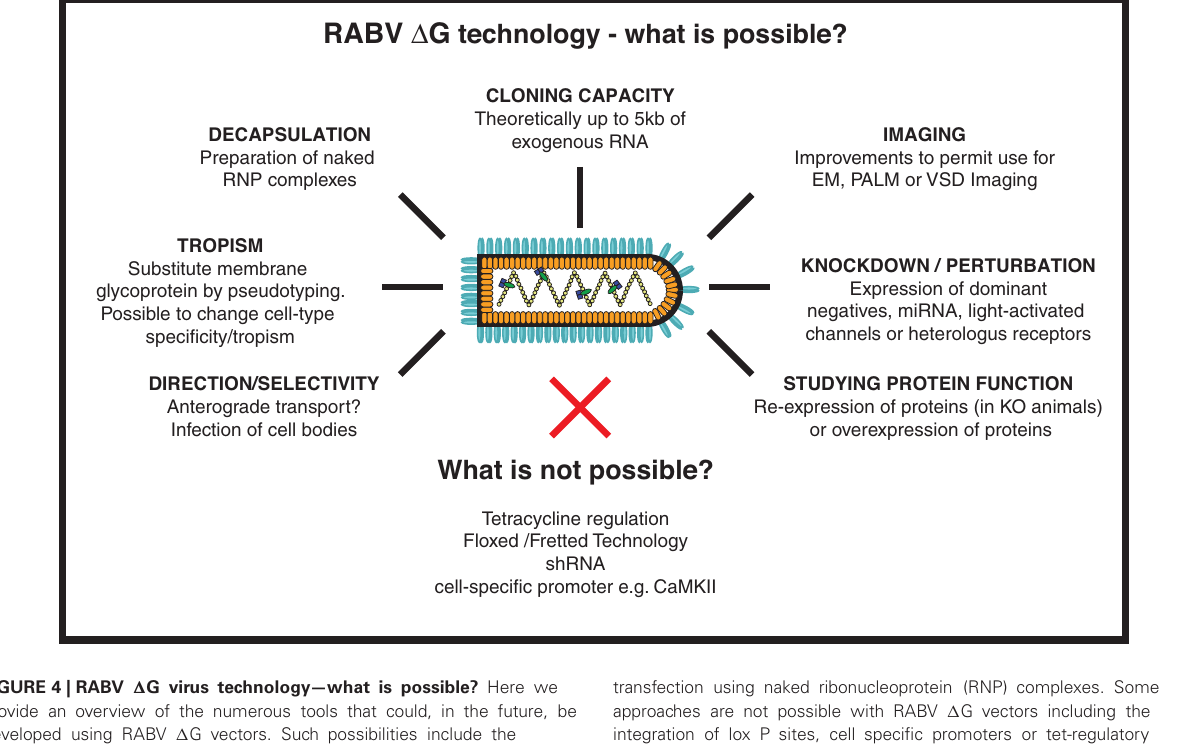
FIGURE 4 | RABV (cid:2) G virus technology—what is possible? Here we provide an overview of the numerous tools that could, in the future, be developed using RABV (cid:2) G vectors. Such possibilities include the expression of genetically encoded tools to aid imaging/microscopy approaches and tools to examine loss-of-function (knockdown) or gain-of-function of a gene/protein of interest. Other possibilities involve retargeting using engineered envelope proteins or the possibility of